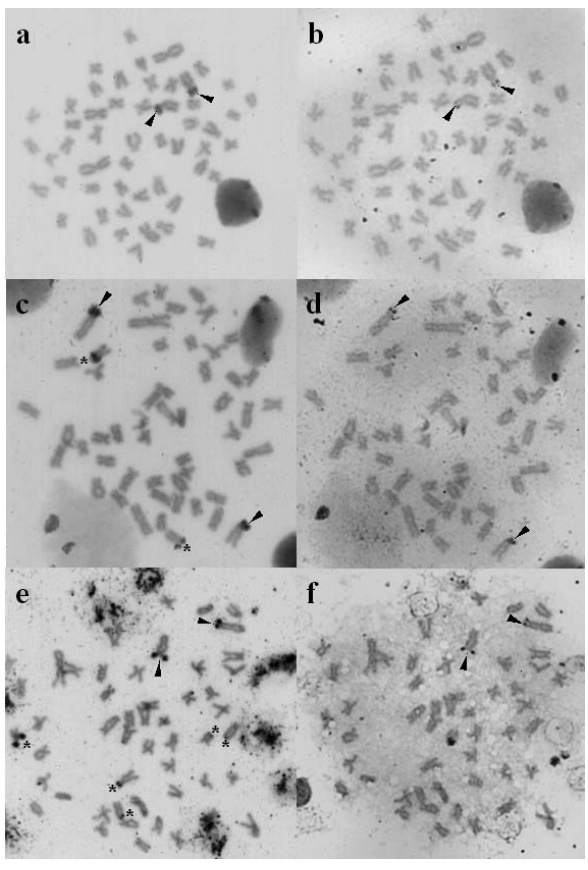
Figure 5 - Metaphases of Triportheus venezuelensis sequentially stained with the FISH technique using an 18S rDNA probe (a, c, e - the original colors were artificially transformed) and with the Ag-NOR technique (b, d, f). Arrows point active Ag-NOR. Asterisks show segments identified with the 18S rDNA probe and not stained in the silver staining experi-